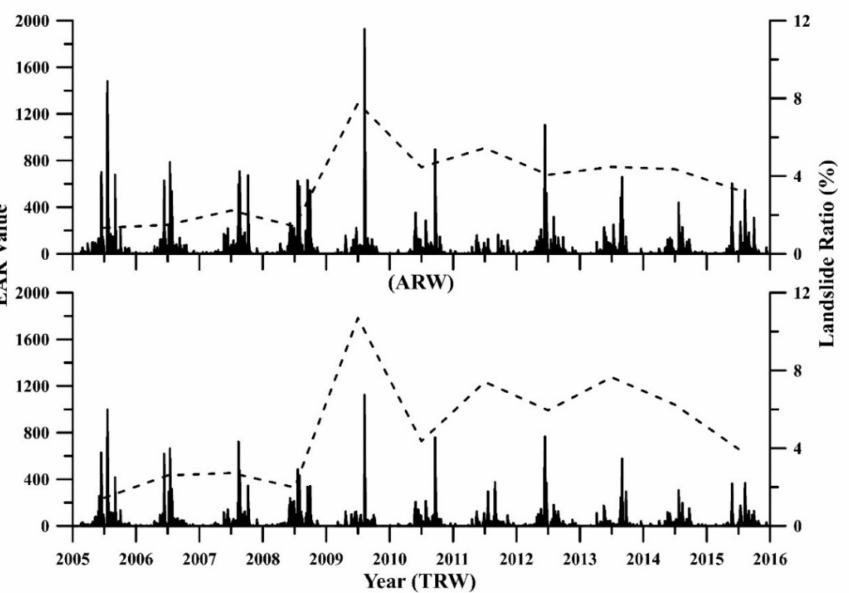
Figure 5. The distribution of effective accumulated rainfall index (abbreviated as EAR) value (black bar) and landslide ratio (dash line) from 2005 to 2015 in the ARW (up figure) and TRW (down figure). The landslide ratios in 2009 in the ARW and TRW (Figure 5) were their historical peaks. The average landslide ratios in the ARW and TRW from 2005 to 2008 were 1.6% and 2.2%, respectively, and those from 2010 to 2015 were 4.3% and 5.9%, respectively. The trends of the landslide ratios in the two watersheds after 2009 were oscillating instead of stably decaying. The EAR h and EAR a in 2011 and 2013 in the ARW were smaller than those from 2005 to 2007, but the landslide ratio increased in 2011 and 2013. Other similar examples are shown in comparing the EAR h , EAR a , and landslide ratios in 2011 and 2013 in